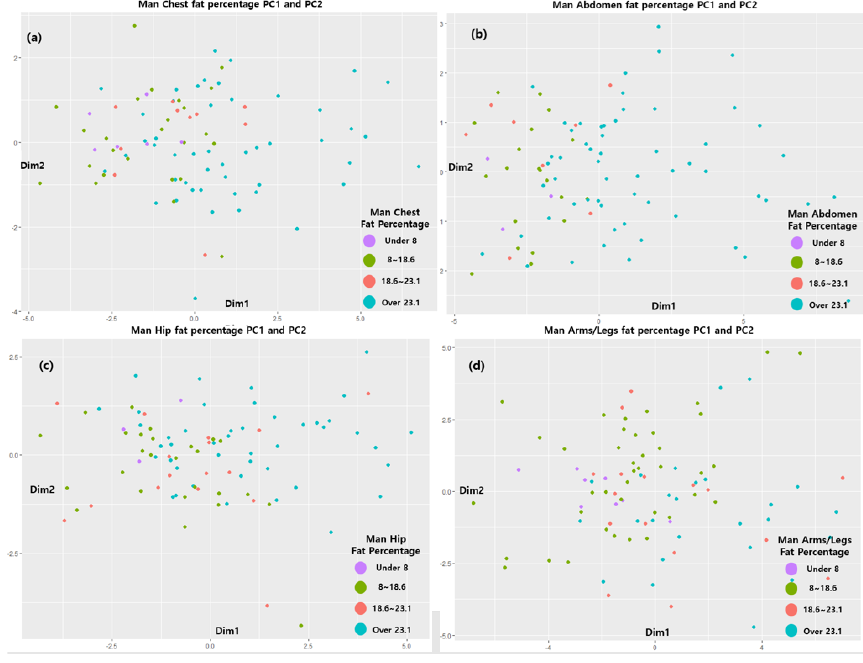
Figure 5. PC 1 and PC 2 results for ( a ) male chests, ( b ) male abdomens, ( c ) male hips, and ( d ) male arms-legs.